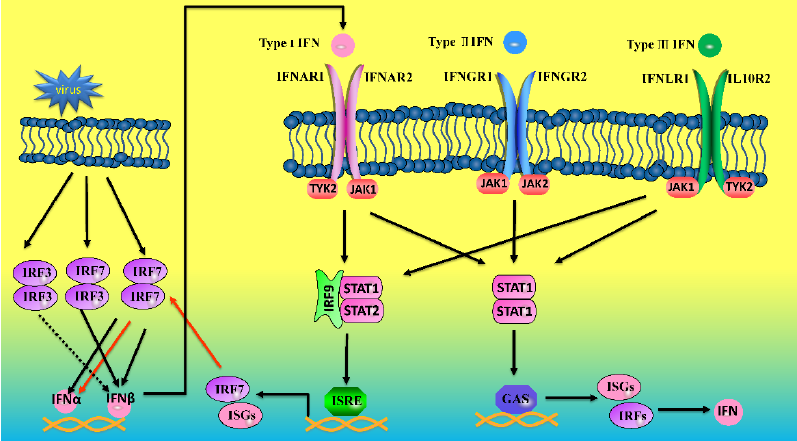
Figure 7. Sketch map of the possible positive feedback antiviral signal pathway of IFN-IFNR in